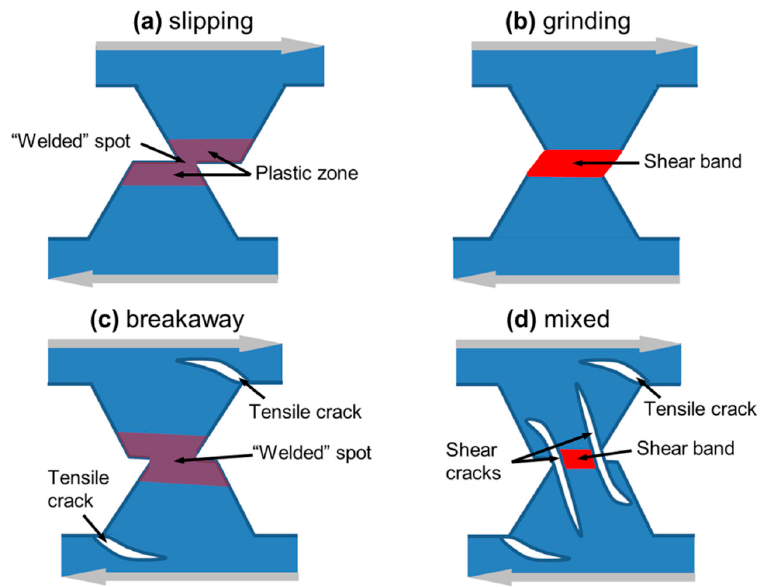
Figure 6. Three wear modes of surface asperities: ( a ) slipping; ( b ) plastic grinding; and ( c ) breaka- way; ( d ) mixed modes. Taken from [66]. ( d ) mixed modes. Taken from